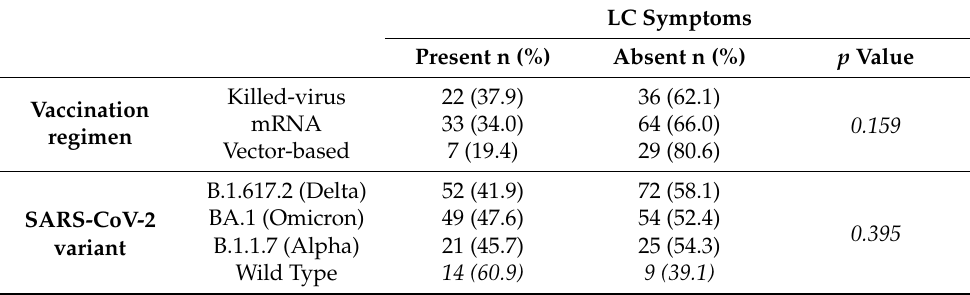
Table 5. Association of LC symptoms with vaccination regimen and SARS-CoV-2